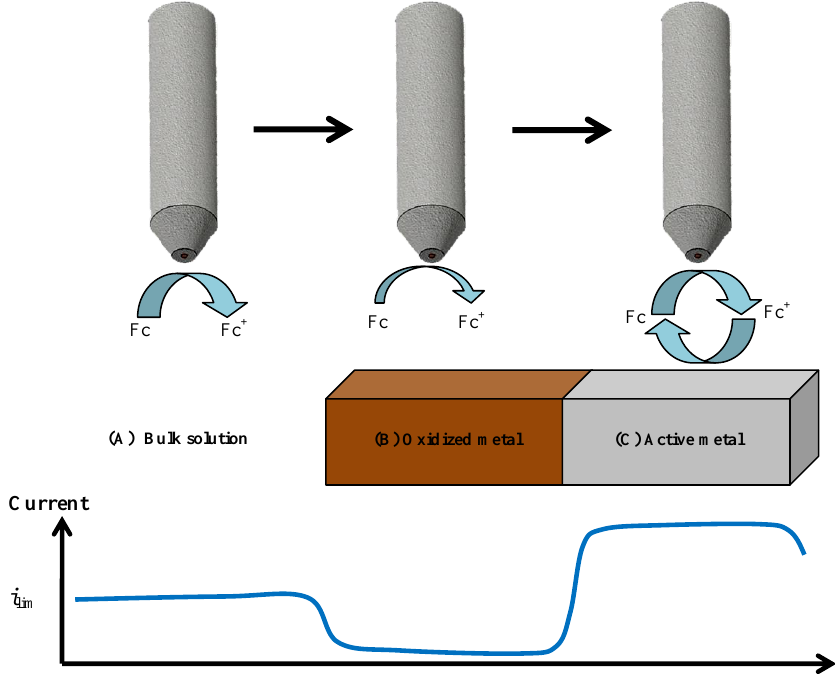
Figure 3. Limiting electrochemical responses for the tip current depending on the surface condition of the Zr-Ti alloys exposed to Ringer′s solution during amperometric SECM operation using ferrocene-methanol (Fc) as redox mediator. ( A ) Current attains a diffusion-controlled limiting current value in bulk solution; ( B ) Negative feedback occurs over the oxide-covered surface, which blocks the diffusion pathways for Fc; ( C ) Positive feedback happens over conductive alloy surfaces that are able to regenerate ferrocene-methanol by reducing the ferrocenium ion (Fc + ) formed at the tip. The heterogeneity of the surface response was evaluated by conducting 2-D scans over a fixed random area of 500 × 500 µ m 2 dimensions for each specimen during the first 24 h. Figure 5 displays Zr-Ti alloys subjected to thermal oxidation in the optimum temperature range were thus selected (cid:48) representative area scans obtained during exposure of the materials to the acidified Ringer s solution. Notice that green color in all scans represent normalized current equal to 1, that is, reproducing the same i lim current value attained for the di ff usion-limited oxidation of the redox mediator in the bulk solution. Hence, normalized current values greater than one (e.g., yellow and red colors)